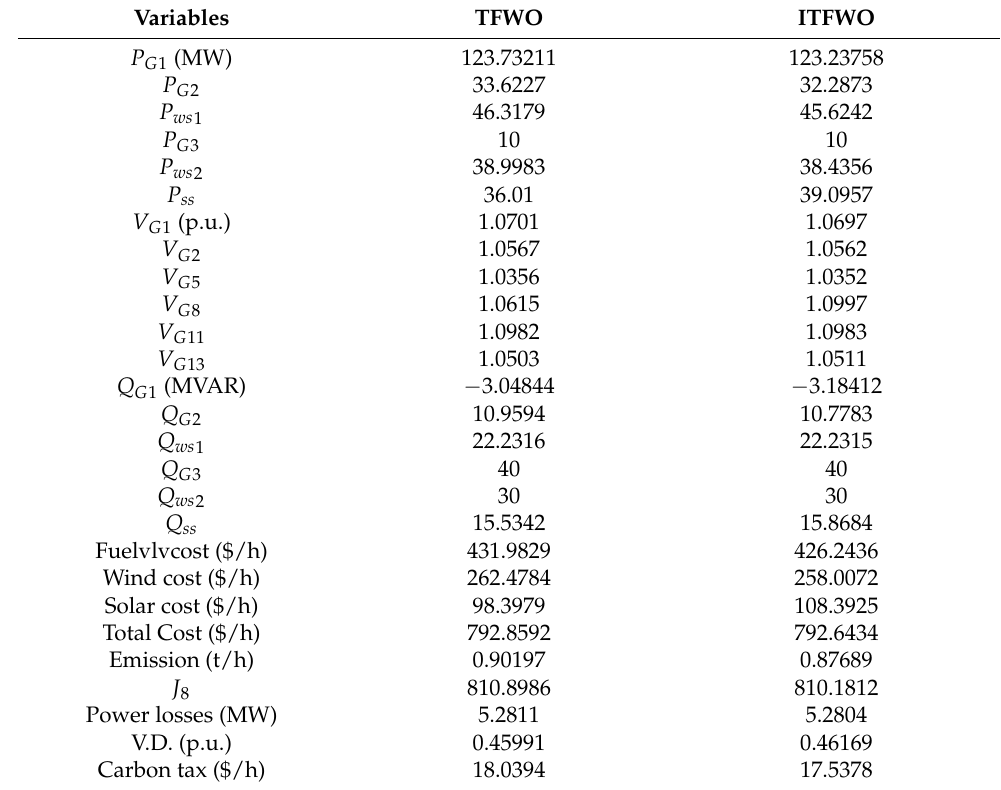
Table 9. The optimization results for Type 8.